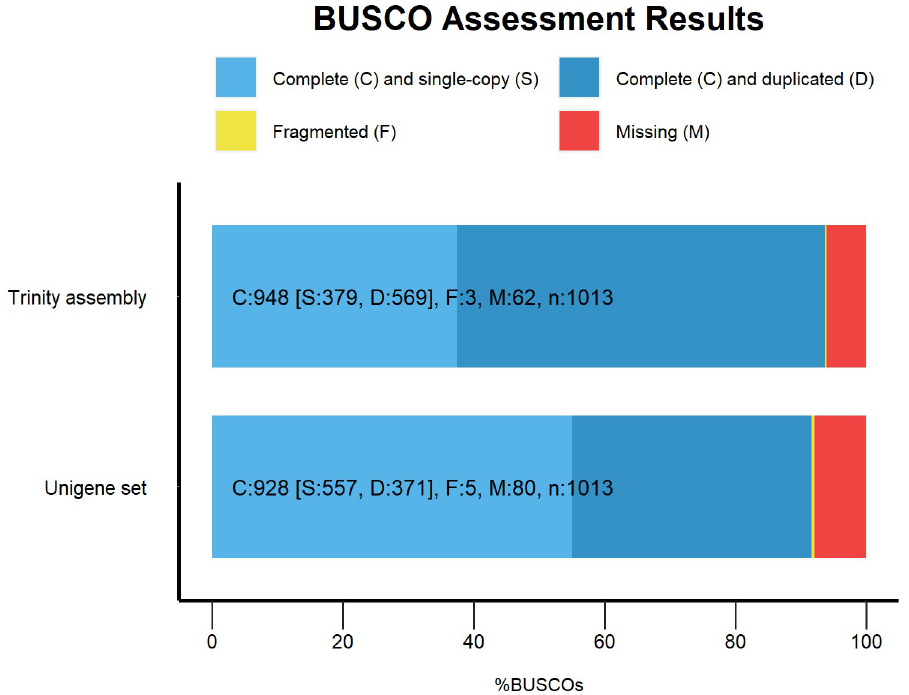
Fig 1. BUSCO completeness assessment. Both the transcriptome and the unigene set are more than 90% complete. Duplication levels are lower in the unigene set.